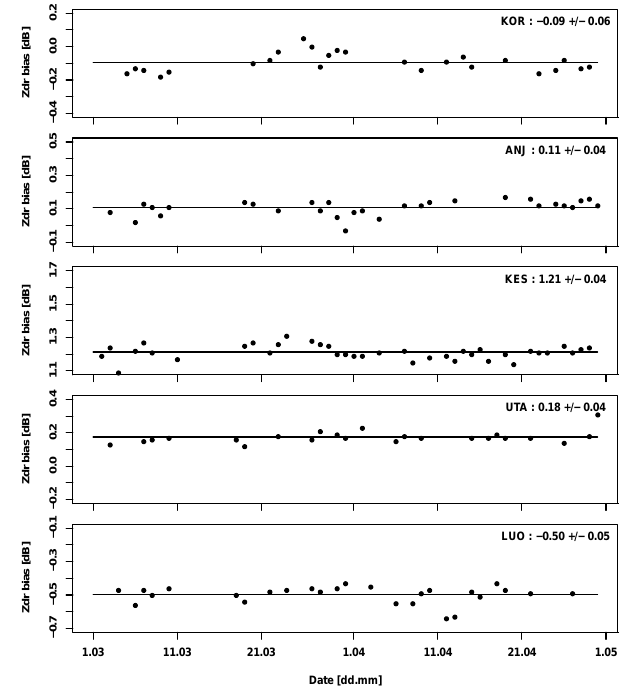
Figure 8. Z dr results from solar signals for March and April 2015 for FMI radars indicated in the panels. The system Z dr bias has not been subtracted from the data. The numbers in each panel give the mean and standard deviation for the data.